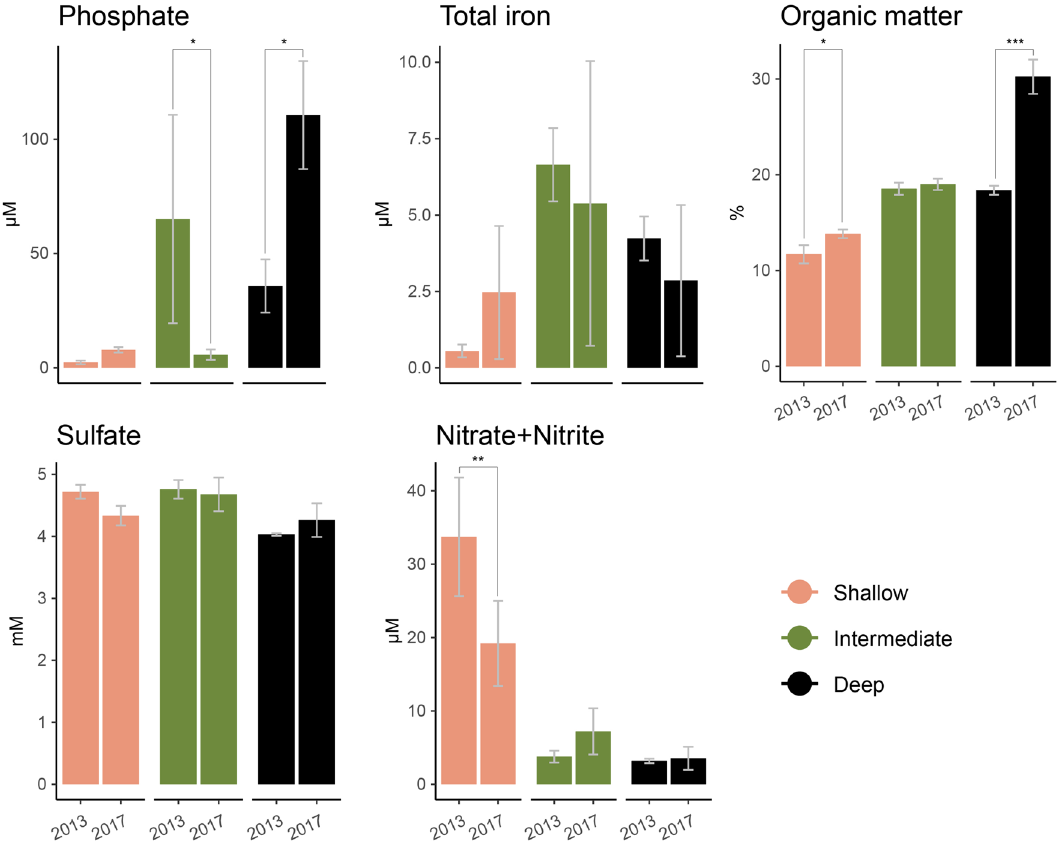
Figure 1. Chemical parameters between 2013 and 2017 in the shallow, intermediate, and deep sites. Chemical parameters were measured on pore water (0–1 cm) for phosphate (µM), total iron (µM), sulfate (mM), and nitrate + nitrite (µM) (in combination) plus on sediment for organic matter (%) in the shallow (salmon), intermediate (green), and deep (black) site in 2013 and 2017. Error bars show the mean and standard deviations ( n = 3 ); significant p-values, ***p < 0.001 **p < 0.01 *p <